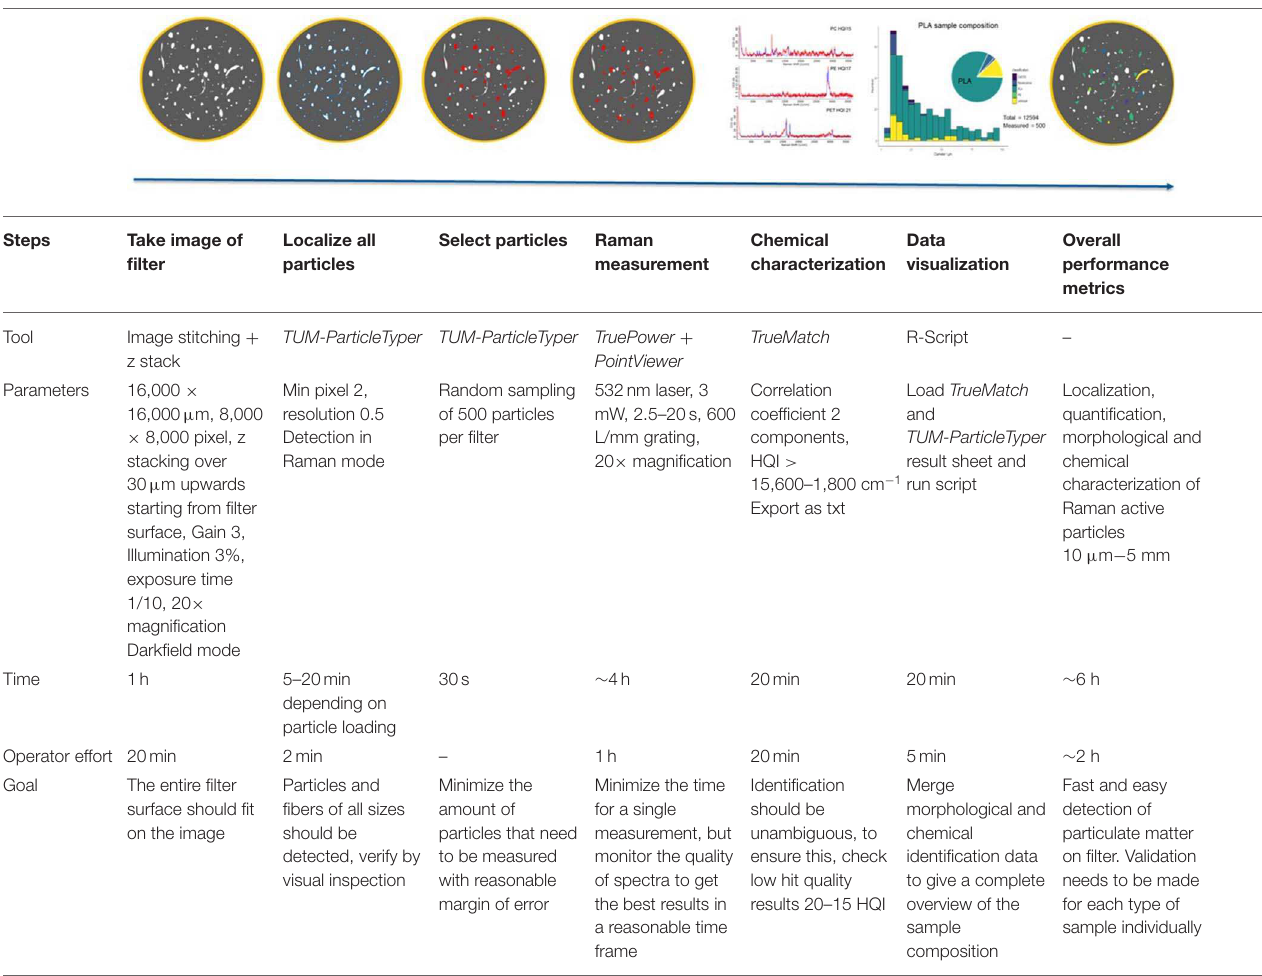
TABLE 1 | Measurement scheme for the Raman microspectroscopic analysis of microplastic, featuring the tools, exact measurement parameters, time, operator effort, and goal for each